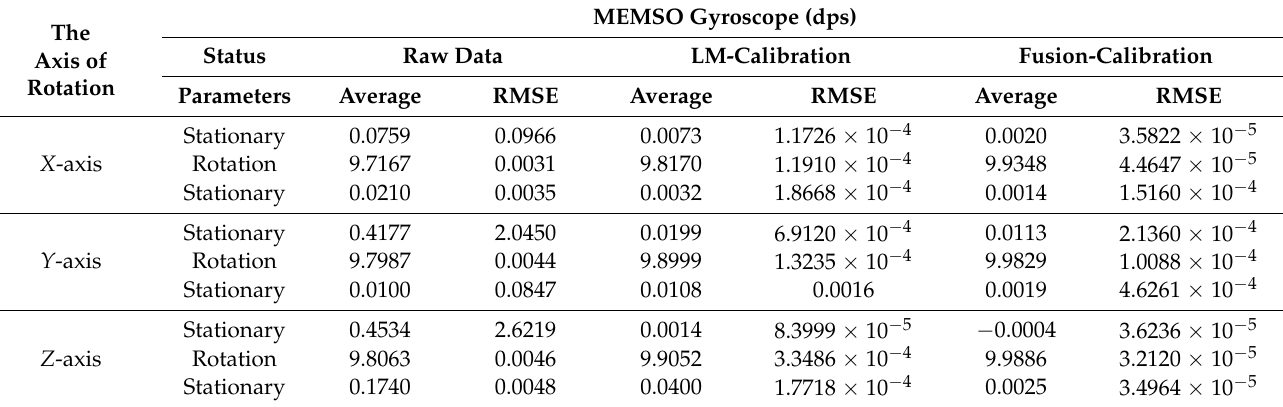
Table 10. Comparison of MEMS0 gyroscope parameters under dynamic